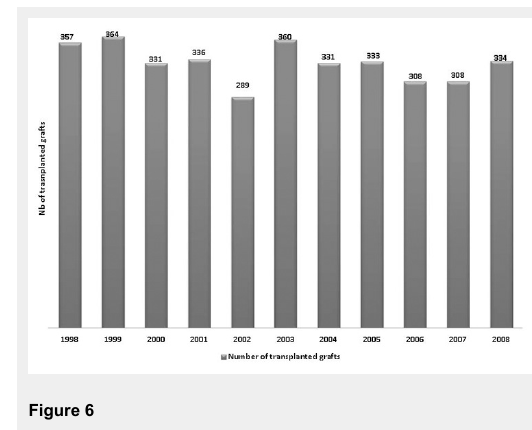
Age distribution of the donors per year, displaying the percentage of donors within the age range of 0 to 15 years, 16 to 55 years, 56 to 64 years and 65 years and above.